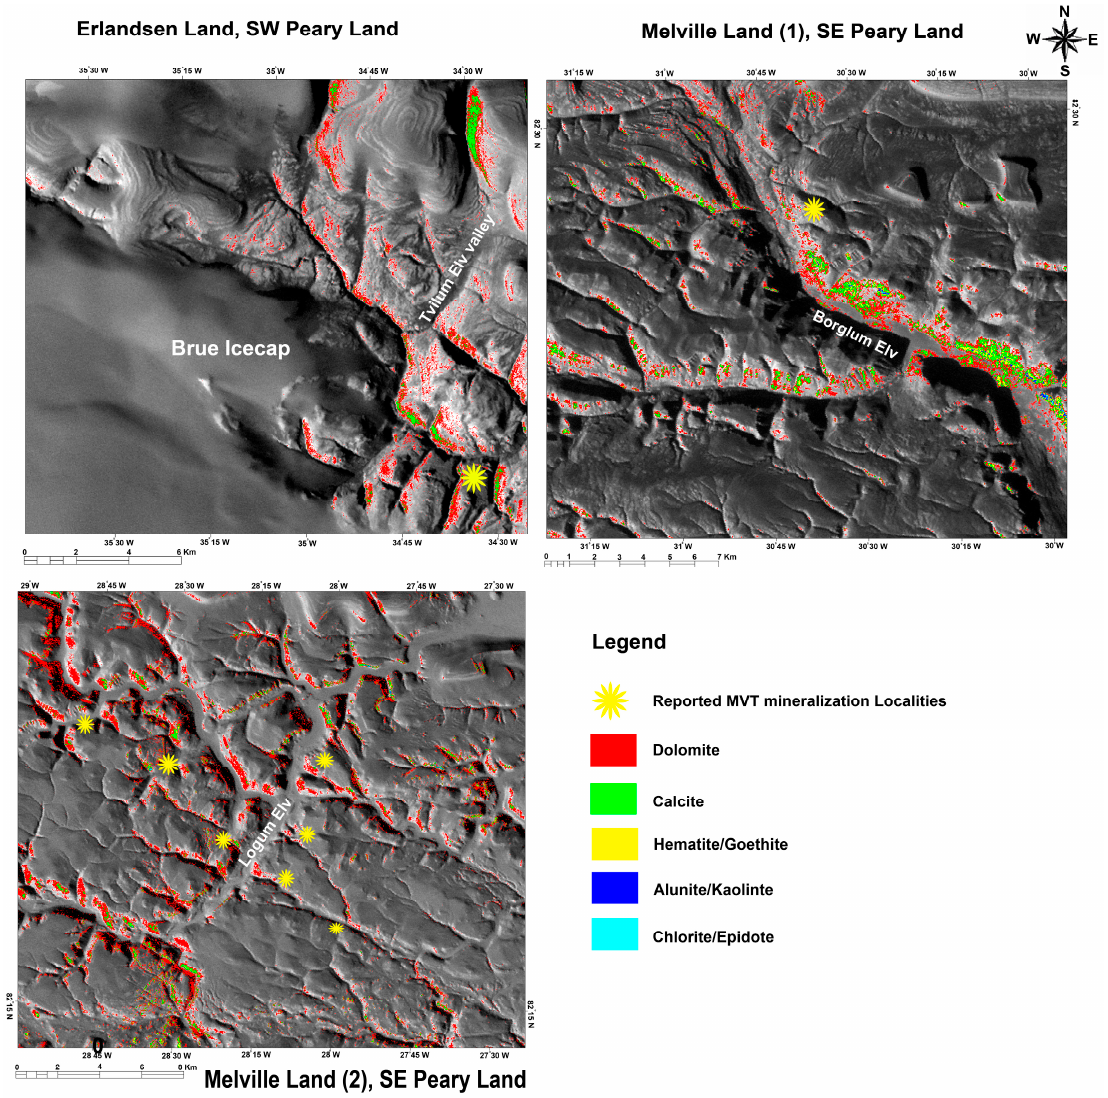
Figure 13. Alteration mineral maps derived from the MF score rule images for selected ASTER spatial subsets in the carbonate shelf platform. ( A ) Erlandsen Land; ( B ) the Melville Land (1); and ( C ) the Melville Land (2).